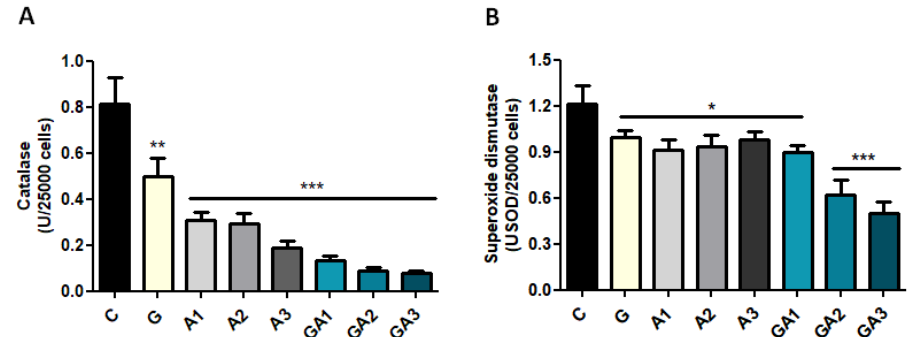
Figure 3. Assessment of CAT ( A ) and SOD ( B ) activity in the CD19 + lymphocytes. Glutathione, allicin and allicin + glutathione (GSSA) significantly decreased CAT and SOD activity in the CD19+ lymphocytes. Values are expressed as mean ± SD (* p < 0.05; ** p < 0.01; *** p < 0.001).